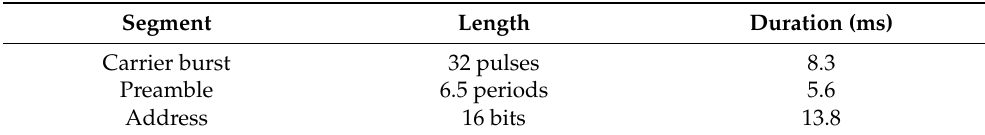
Table 3. Structure of the WuPt with length.